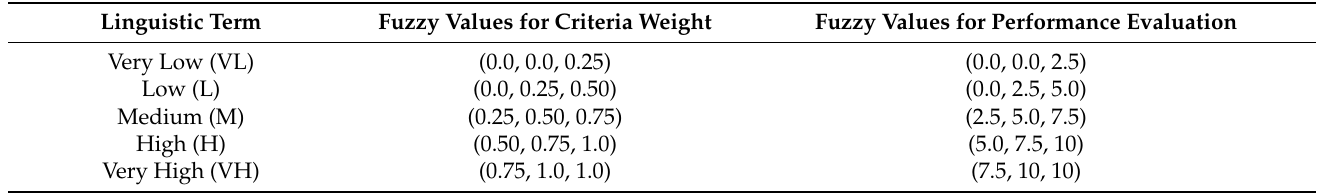
Table 2. Fuzzy number scale for level of importance (weight) of decision criteria and performance evaluation of criteria.